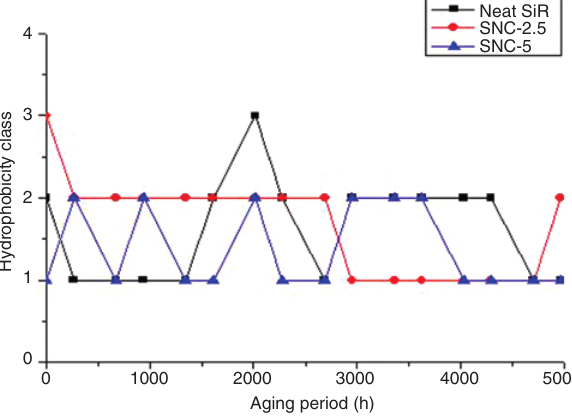
Figure 6: Hydrophobicity class variation in neat SiR, SNC-2.5, and SNC-5 with aging.